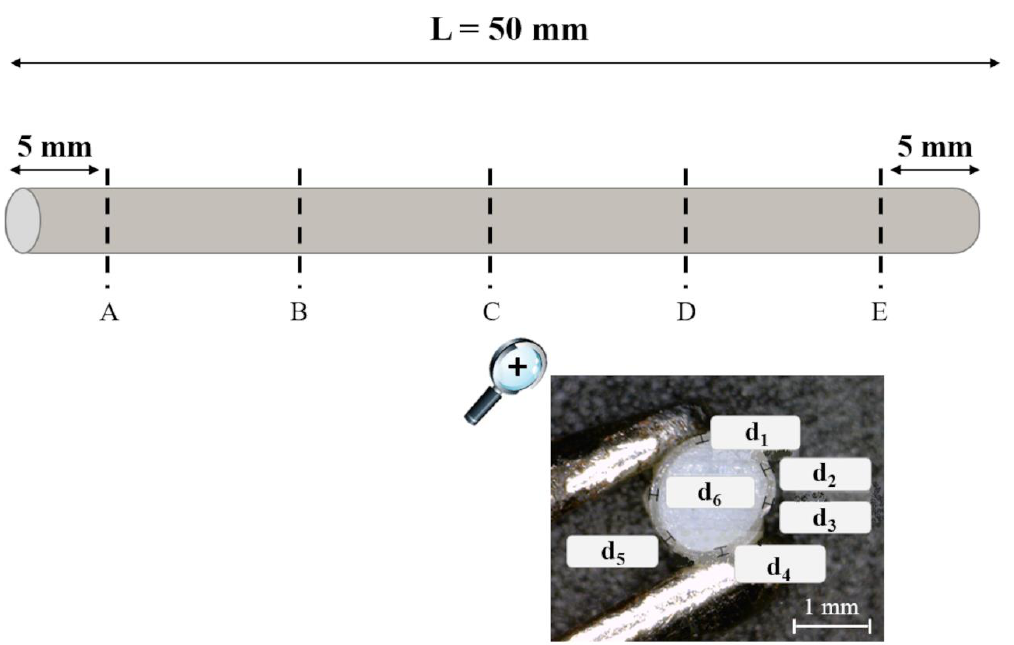
Figure 2. Outline of the A-E positions where I-shaped samples were cut and photographed, showing a cross-section with details relevant to the d 1 -d 6 coating thickness measurements.